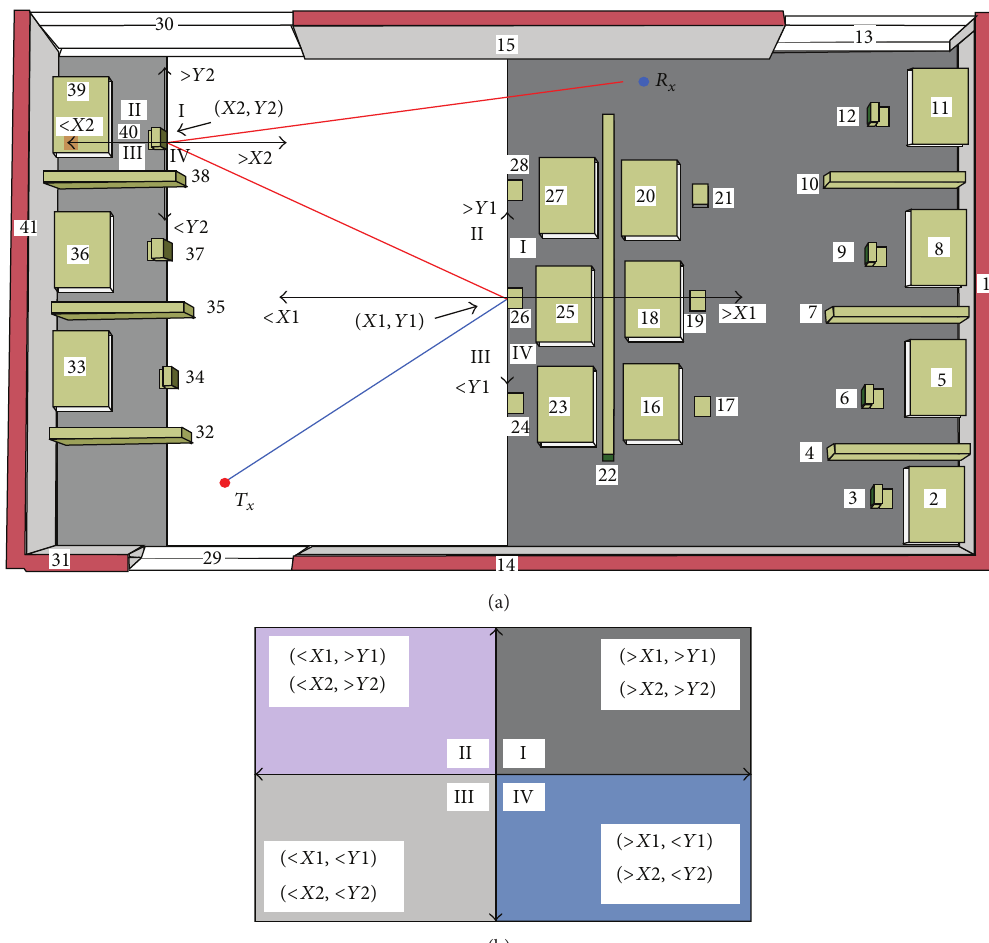
Figure 5: (a) Object skipping using DQS technique in a sample environment and (b) object allocation due to